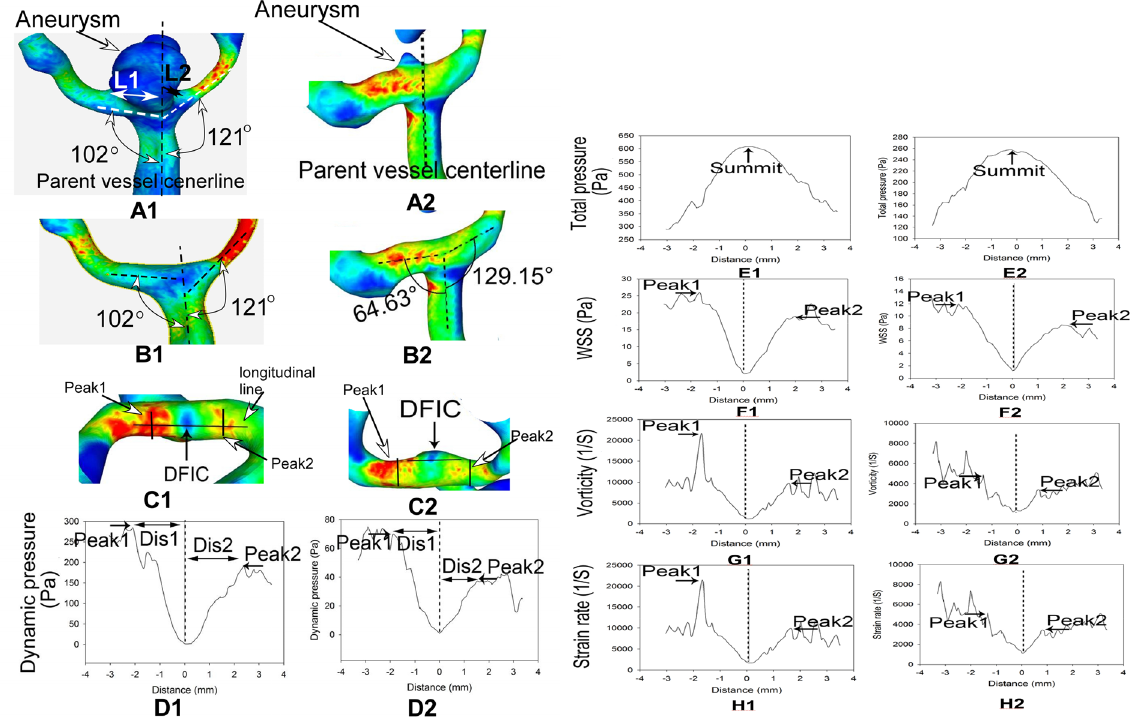
Figure 2. Line sampling of hemodynamic stresses on the bifurcation apex wall. ( A1 – H1 ) An unruputred anterior communicating artery (Acom) aneurysm and sampling on the bifurcation apex after virtual aneurysm removal. ( A1 ) The Acom aneurysm was shown. L1 was larger than L2, and the aneurysm deviated towards the L2 side. B1-C1. After the aneurysm was virtually removed ( B1 ), a longitudinal line was drawn on the top of the bifurcation apex across the flow direct impinging center (DFIC), Peaks 1 and 2 ( C1 ) to sample the hemodynamic stresses including the dynamic pressure, total pressure, wall shear stress (WSS), vorticity, and strain rate. ( D1 – H1 ). The profiles of hemodynamic stresses on the longitudinal line were shown. There were two peaks of stresses on the line: Peaks 1 and 2. Dis represented the distance from the DFIC to Peak 1 or 2. Distance 0 indicated the DFIC where the flow direction was perpendicular to the wall. Beyond Peak 1 or 2, the flow direction was parallel to the arterial wall. ( A2 – H2 ). An unruputred Acom aneurysm in a 580 year-old man. ( A2 ) The Acom aneurysm was shown. ( B2 – C2 ) After virtual aneurysm removal ( B2 ), a longitudinal line was drawn on the bifurcation apex to smaple the hemodynamic stresses ( C2 ). D2 – H2 . The profiles of hemodynamic stresses on the longitudinal line were shown, similar to those in ( D1 – H1